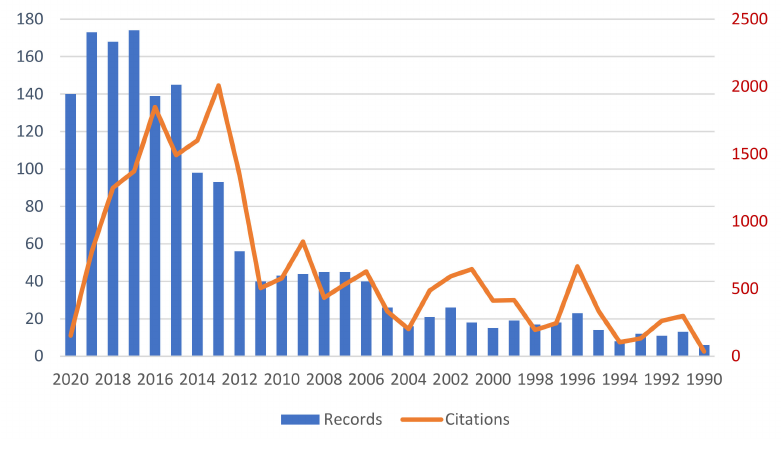
Figure 5. Number of publications and citations